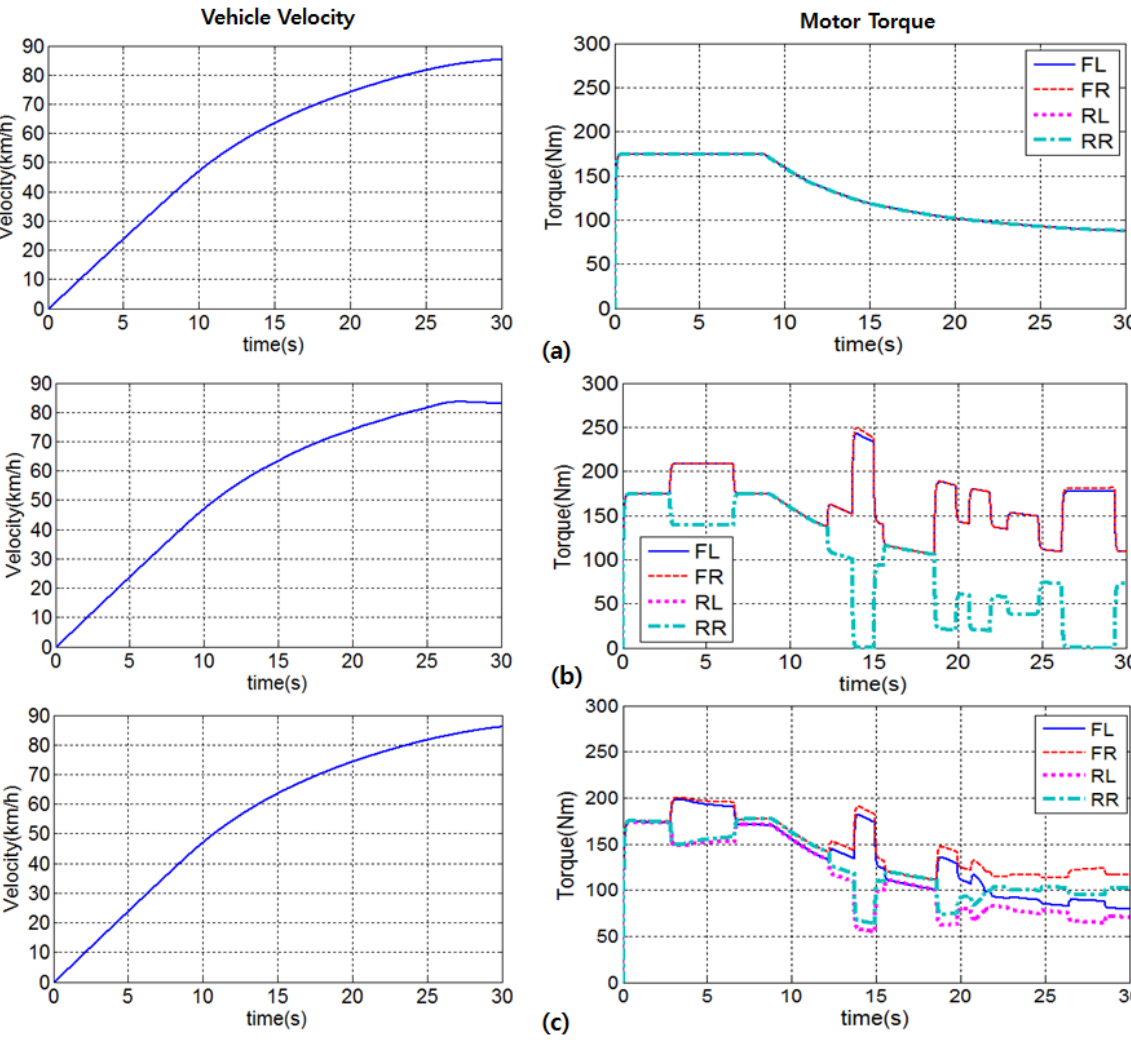
Figure 14. Simulation results of vehicle velocity and motor torque during circular drive: ( a ) fixed torque distribution; ( b ) applying distribution torque considering vehicle efficiency; ( c ) applying integrated torque distribution